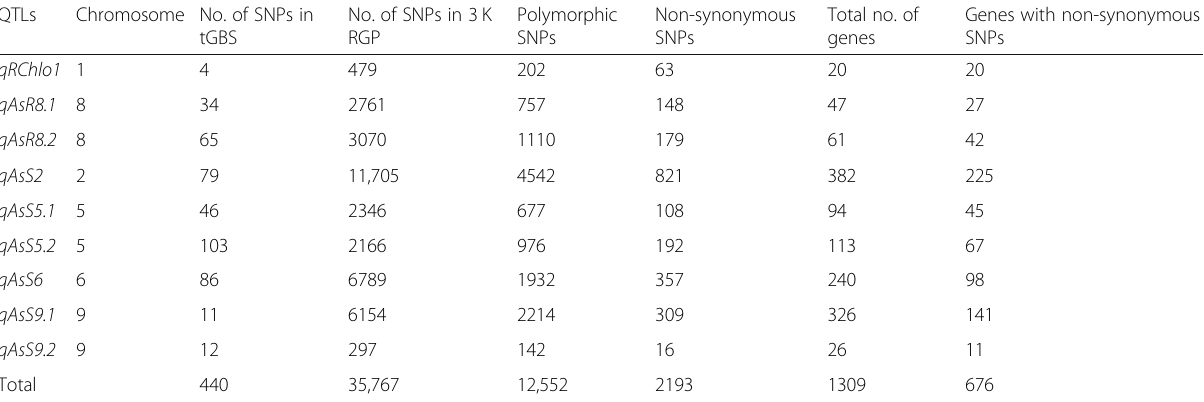
Table 3 SNPs identified in the QTL regions using tGBS and 3 K RGP QTLs Chromosome No. of SNPs in tGBS